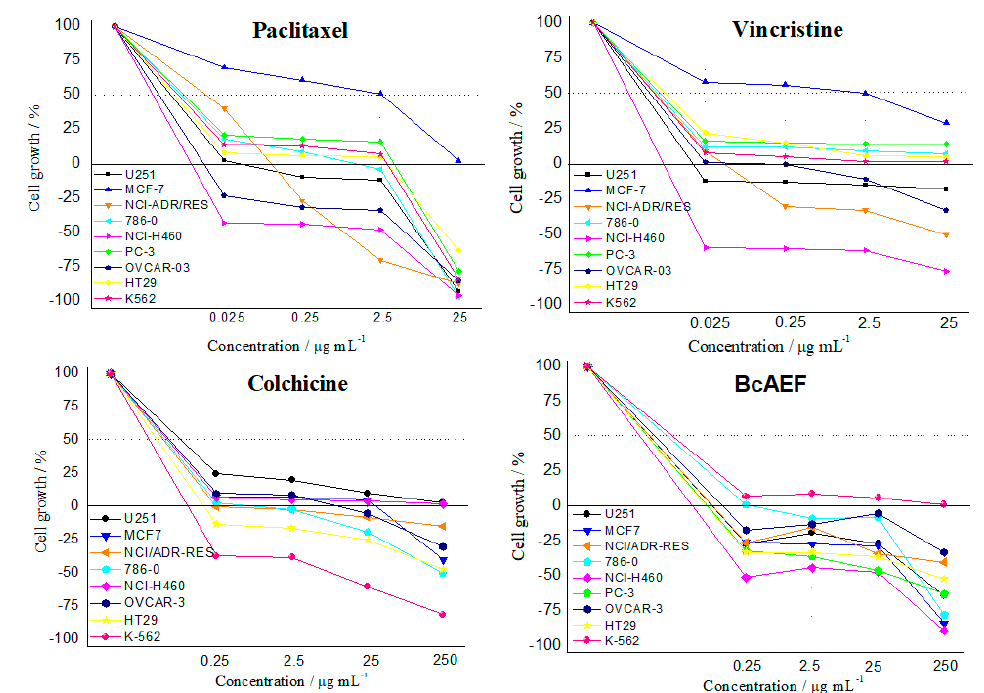
Figure 1. Antiproliferative profiles of paclitaxel (0.025 to 25 µ g mL − 1 ), vincristine (0.025 to 25 µ g mL − 1 ), colchicine (0.25 to 250 µ g mL − 1 ), and BcAEF (0.25 to 250 µ g mL − 1 ) after 48h-exposition over a panel of tumor cell lines. Human tumor cell lines: U251 (glioblatoma); MCF-7 (breast, adenocarcinoma); NCI-ADR / RES (multidrug resistant ovarian adenocarcinoma); 786-0 (kidney, adenocarcinoma); NCI-H460 (lung, large cells carcinoma); PC-3 (prostate, adenocarcinoma); OVCAR-3 (ovarian, adenocarcinoma); HT29 (colon, adenocarcinoma); K562 (chronic myeloid leukemia). For colchicine the PC-3 cell line is not presented due to an experimental error.